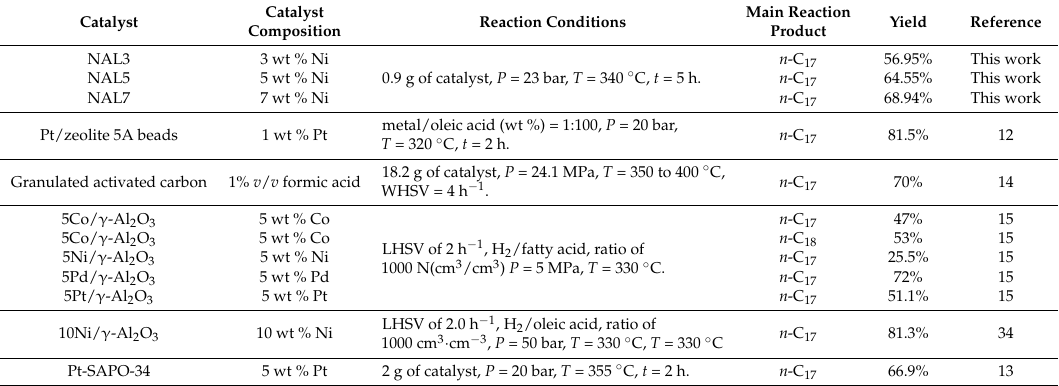
Table 3. n -C 17 yields with Ni/ γ -Al 2 O 3 catalysts and other catalysts in the oleic acid hydrodeoxygenation.